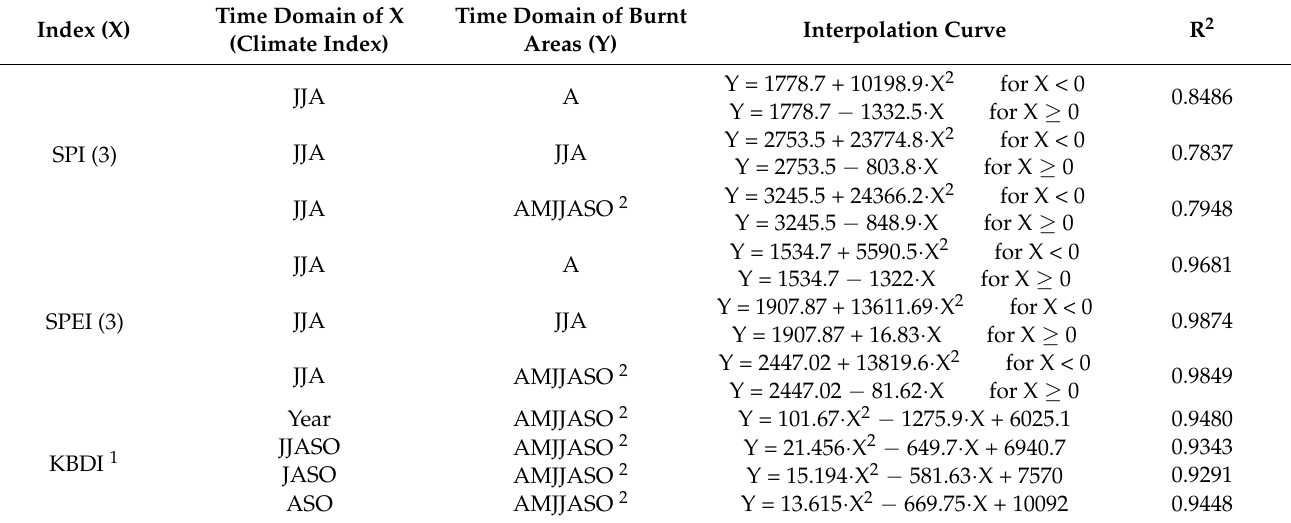
Figure 4. The best fitting models between burnt areas and climate index: ( a ) SPI(3) in August and A-burnt areas; ( b ) SPEI(3) in August and JJA-burnt areas; ( c ) mean annual KBDI and seasonal (AMJJASO) burnt areas. Table 6. The best fitting models between the climate indices SPI, SPEI, KBDI and the burnt areas (in hectares) for the whole territory of